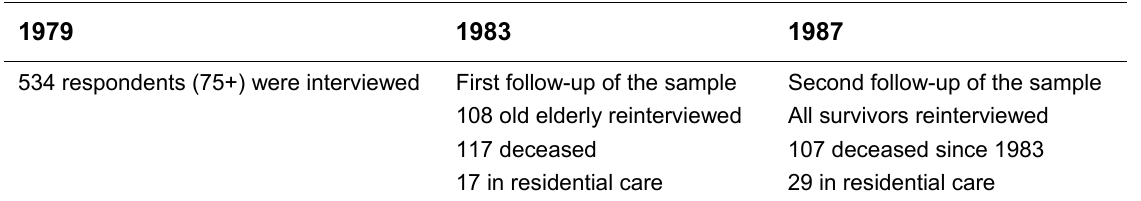
The Structure of the Longitudinal